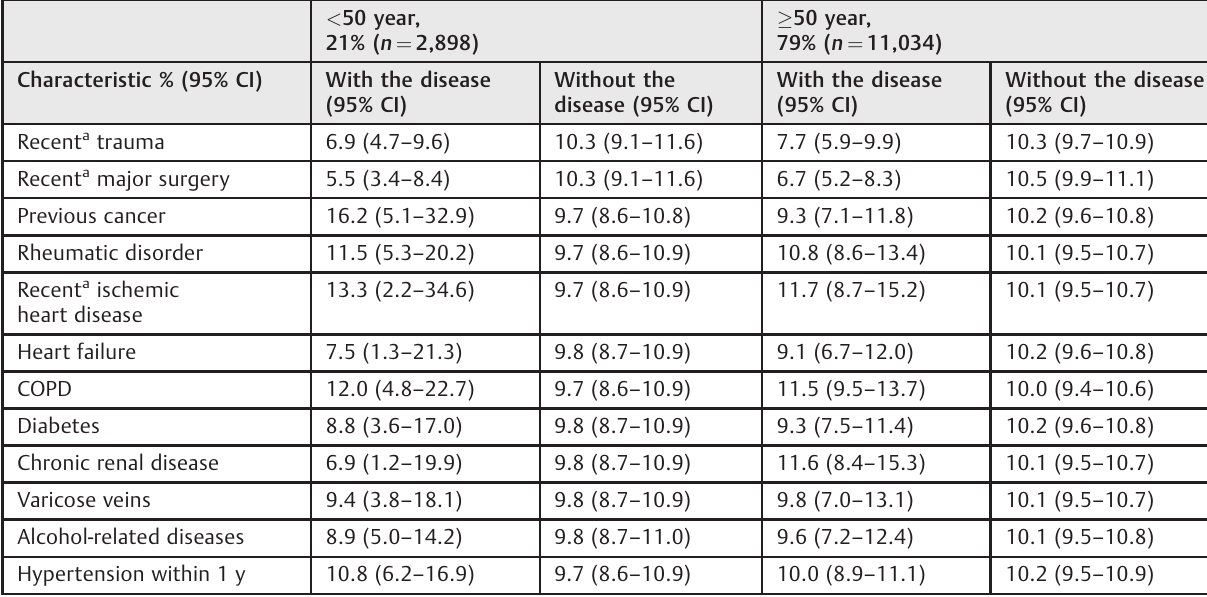
Table 2 Cumulative recurrence risk at 2 year after anticoagulant treatment discontinuation according to selected patient characteristics, strati fi ed by age